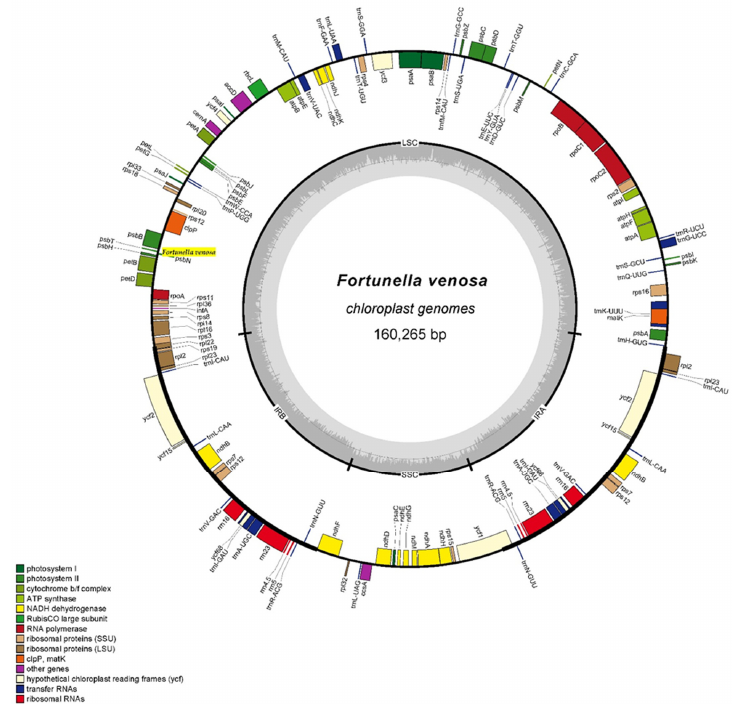
Figure 1. Gene map of the Fortunella venosa chloroplast genome . Genes drawn inside the circle are transcribed clockwise, and those outside are transcribed counterclockwise. Genes belonging to different functional groups are color coded. The darker gray color in the inner circle corresponds to the GC content, and the lighter gray color corresponds to the AT content.